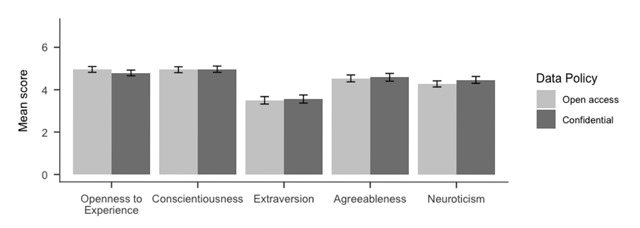
Mean scores of the Ten-Item Personality Inventory (Gosling et al., 2003) by subscale and consent condition. Answers were given on 7-point Likert scales.